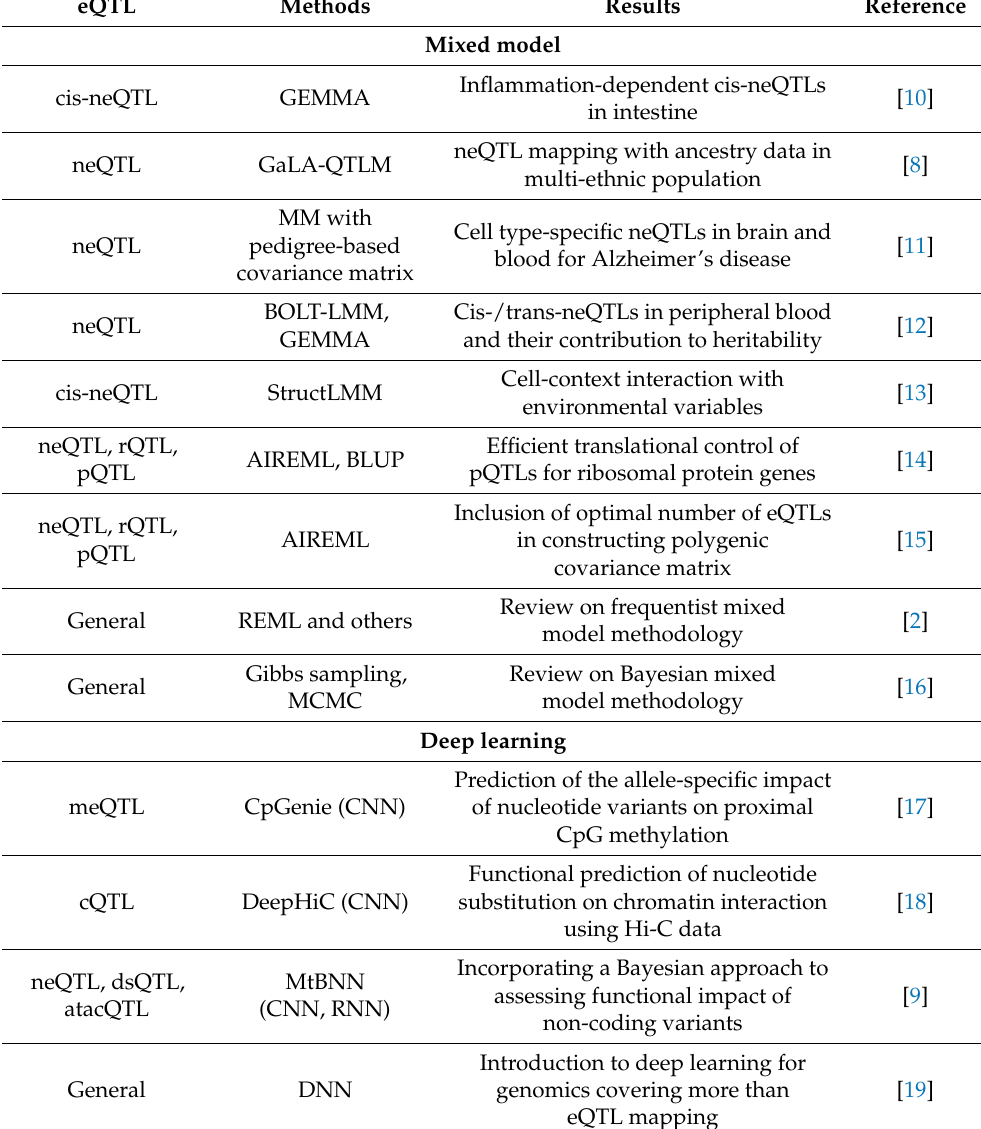
Table 1. Examples of eQTL studies and reviews using a mixed model or a deep